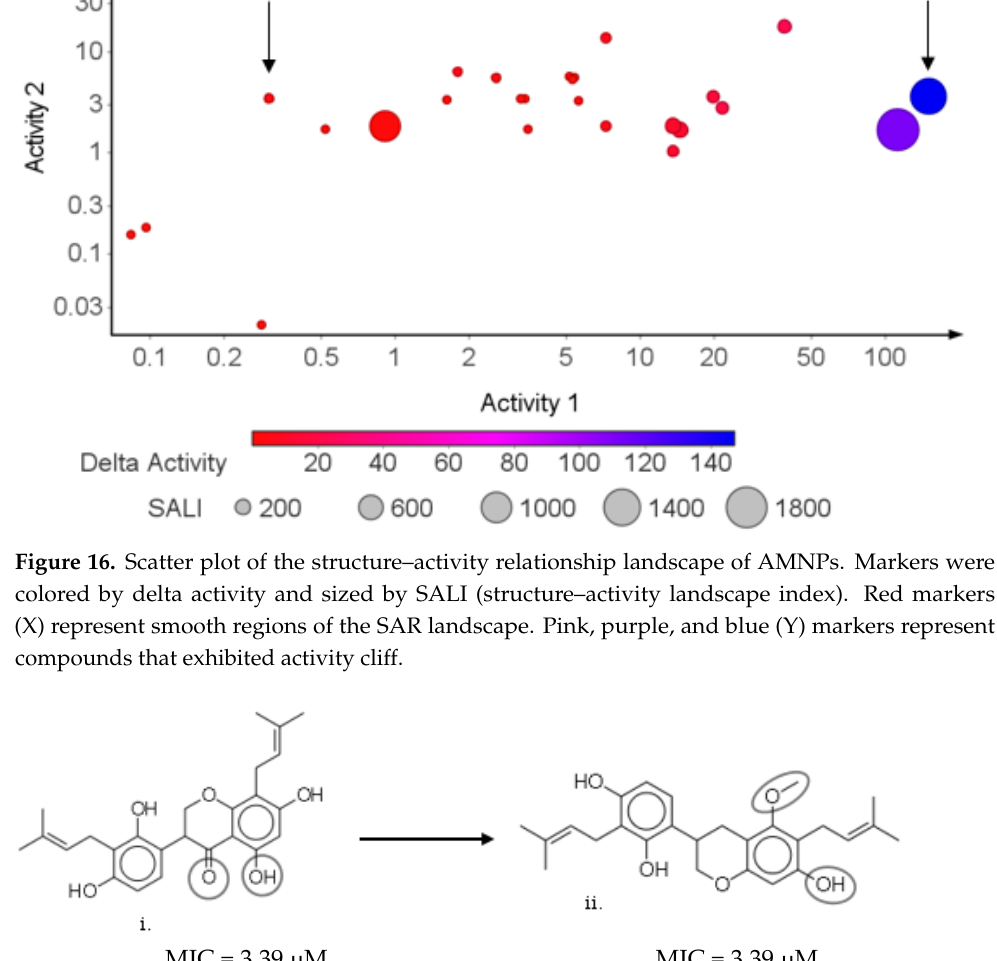
Figure 17. A pair of similar AMNPs (X) with little or no difference in bioactivity. The addition of hydroxyl (the small circle) in structure (ii) to the naphthalene ring in structure (i) did not cause any changes in bioactivity (MIC values). Hence, the two structures have about 87% structural similarity and the same bioactivity (delta activity = 0 µg/mL). Molecules 2020 , 25 , x